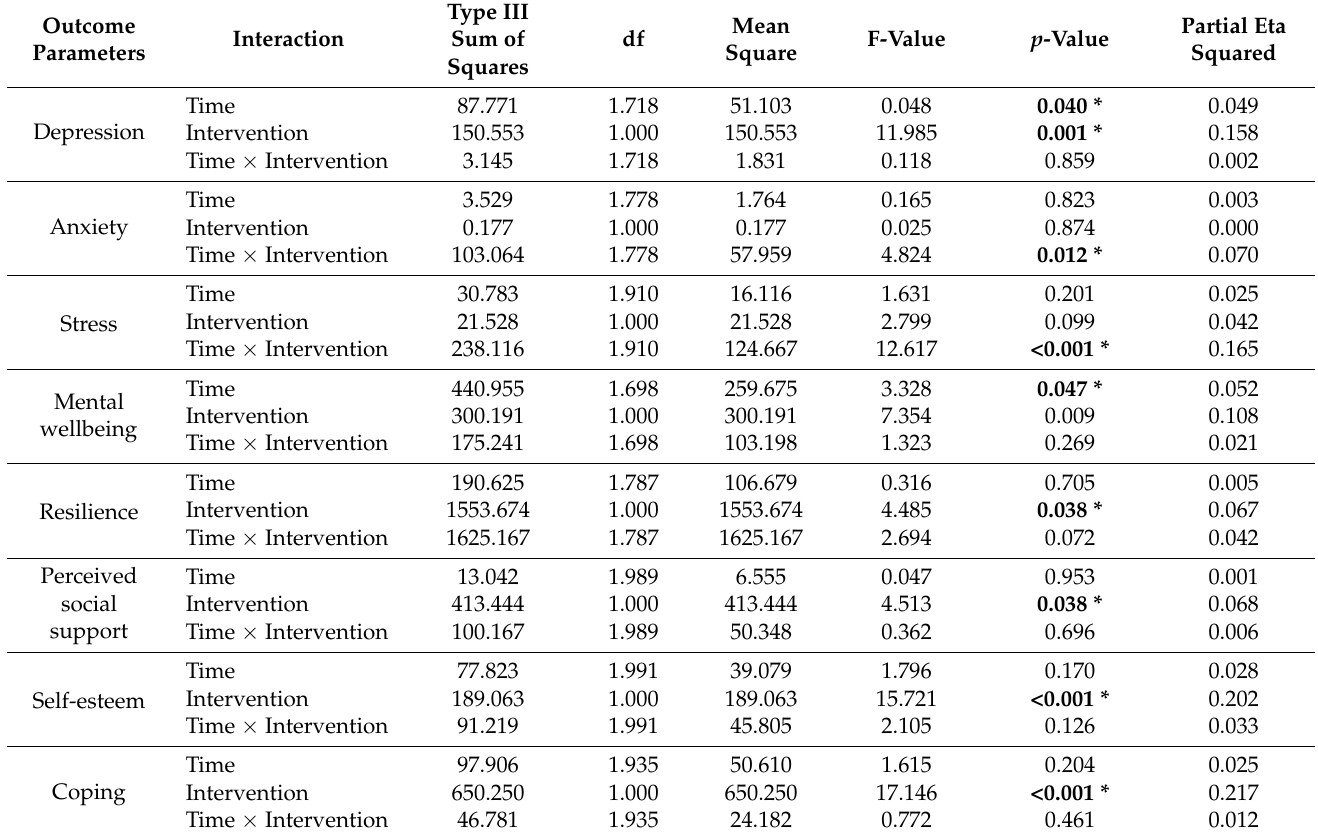
Table 6. A 2-way interaction between time and intervention on mental health status, resilience, perceived social support and self-esteem of participants.